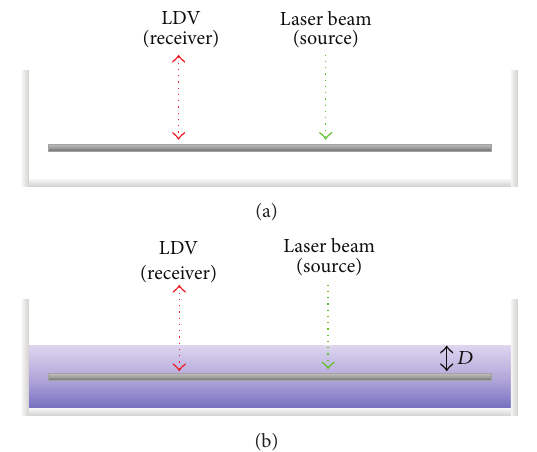
Figure 4: Experimental model in different conditions: (a) free plate in air and (b) immersed plate.